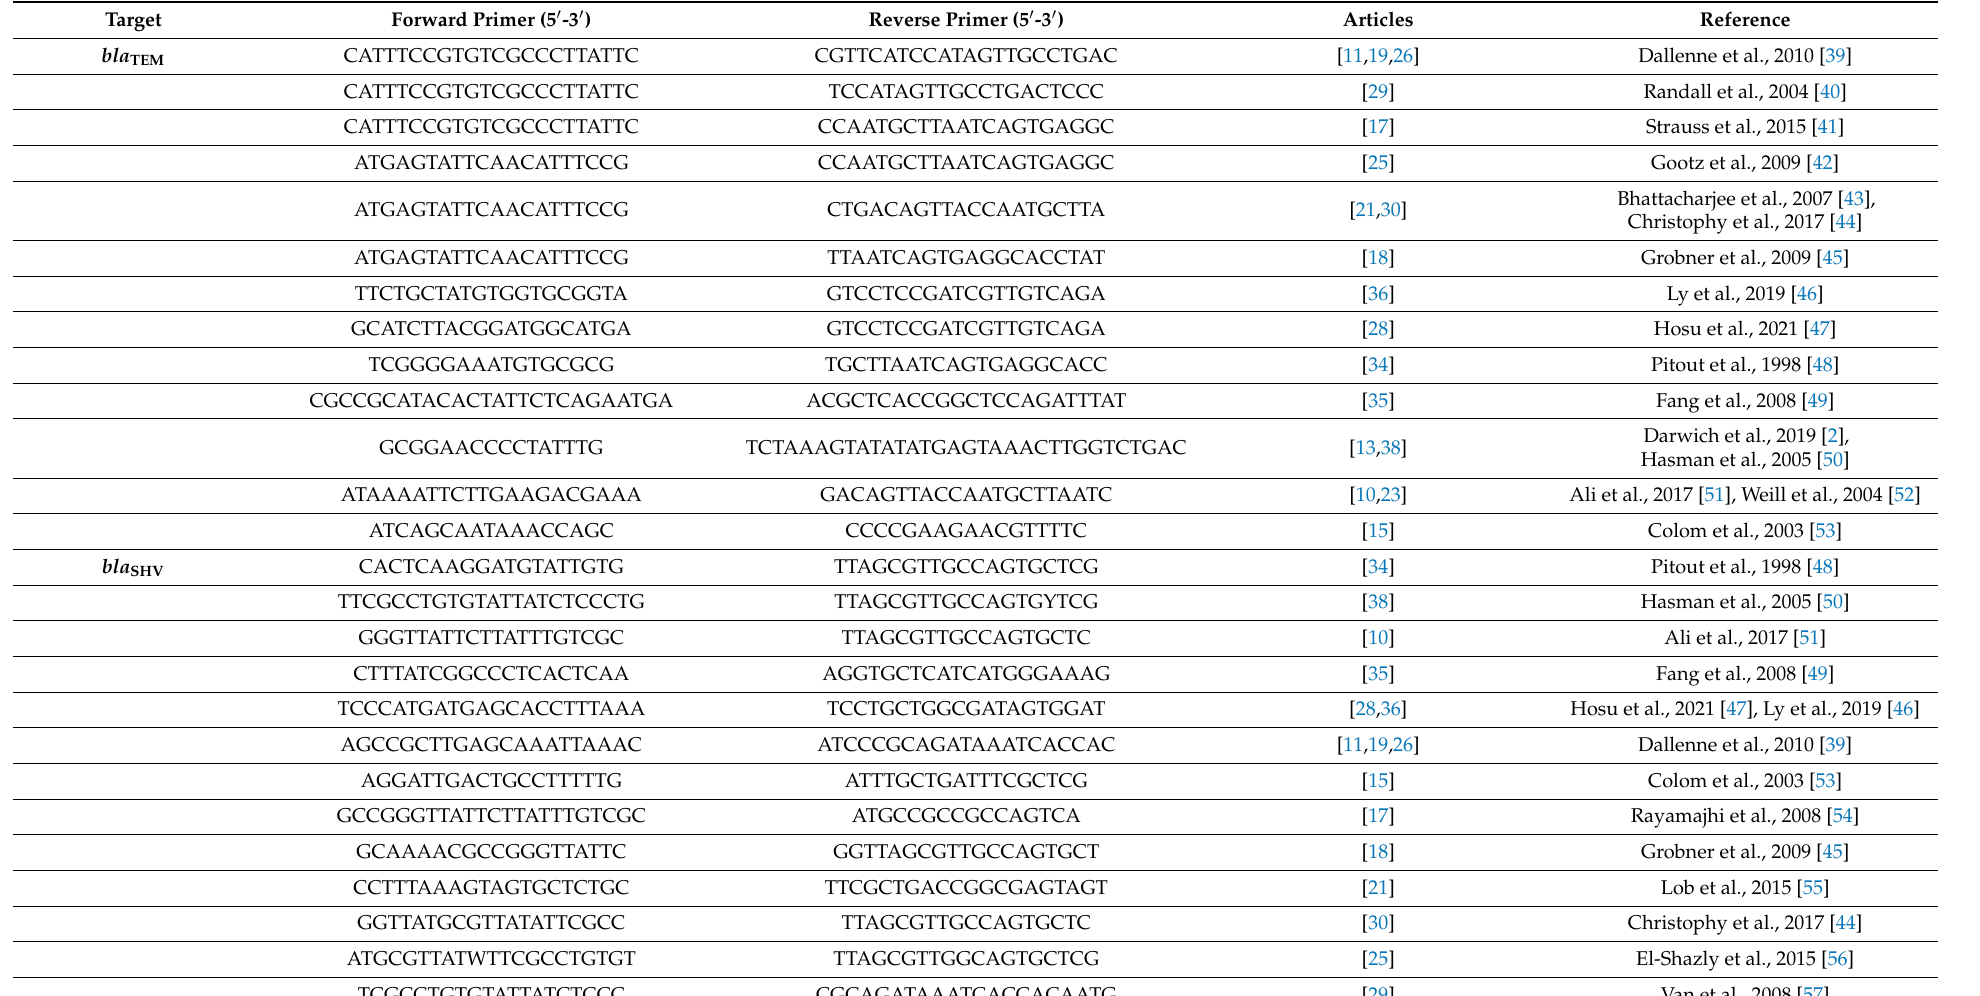
Table 3. Primers used for detecting ESBL-encoding genes in the